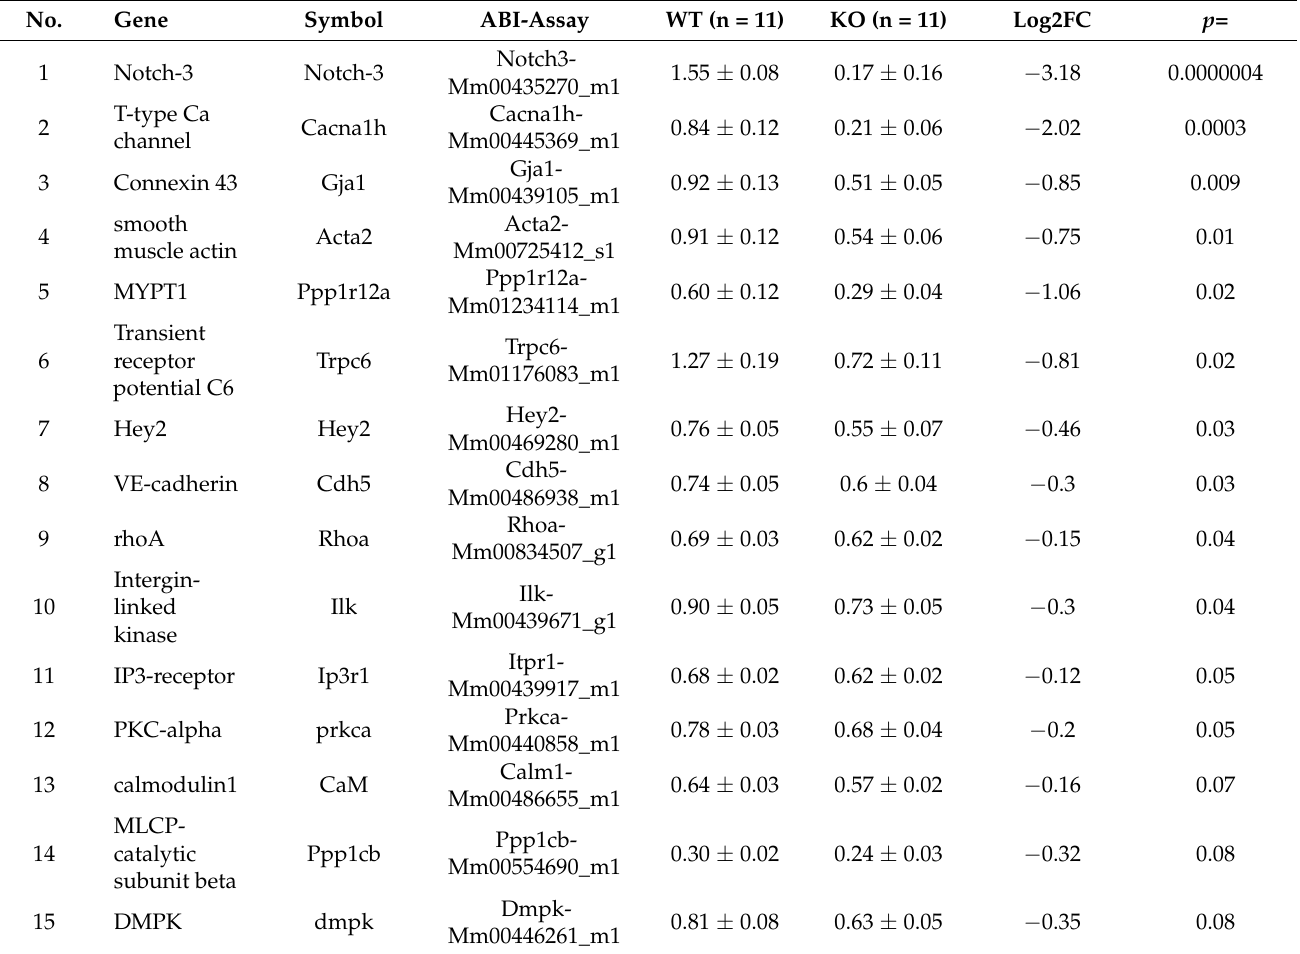
Table A1. Comparative real-time PCR mRNA expression of 47 genes related to contractile function in the afferent arterioles from Notch3 − / − and wild-type littermates. Note that the expression of Cacna1h coding the α 1H subunit of the T-type Ca 2+ channel (Ca v 3.2) gene was strongly downregulated in Notch3 − / − ( p < 0.001 vs. wild-type). In contrast, Cacna1c coding the α 1C subunit of the L-type Ca 2+ channel was similarly expressed in the two strains (No. 26 on the